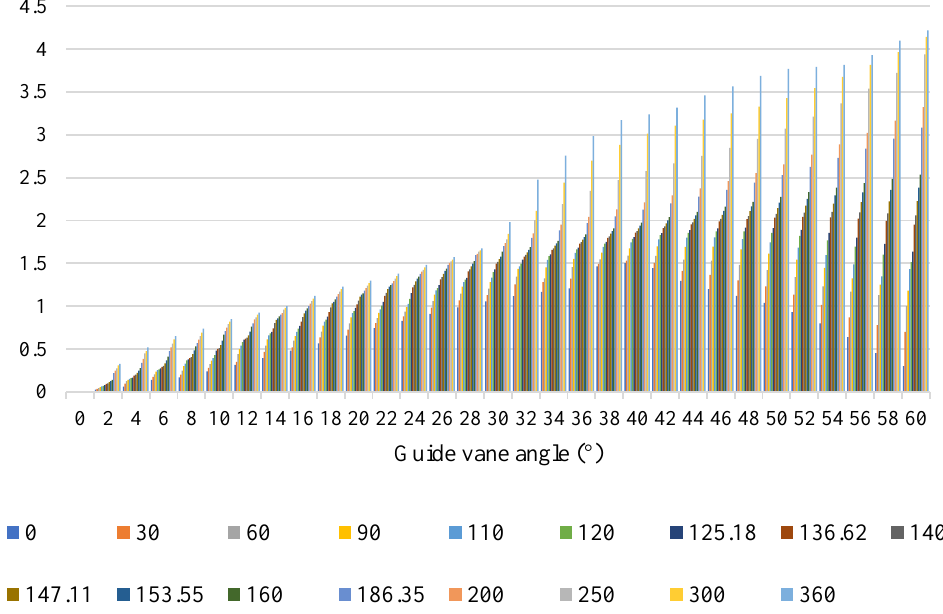
Figure 10. The relationship among unit discharge, guide vane opening, and unit rotation speed when the blade angle is 14 degrees.